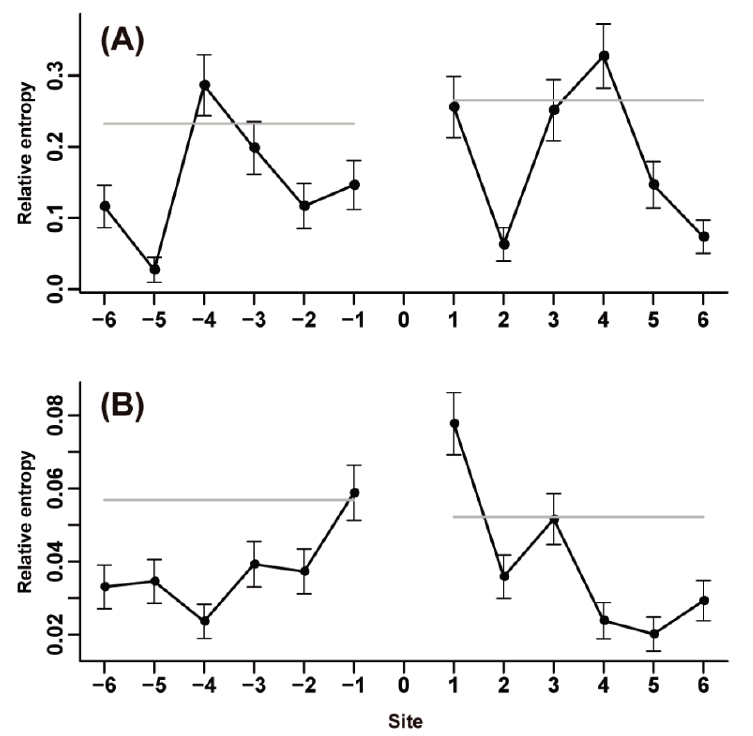
Figure 6. Context-dependence pattern of G → E substitution in α -helix and coil. ( A ) Context-dependence pattern of the G → E substitution in α -helix; ( B ) Context-dependence pattern of the G → E substitution in coil. (Boxplots of this amino acid substitution type in α -helix and coil can be found in Figures S6 and